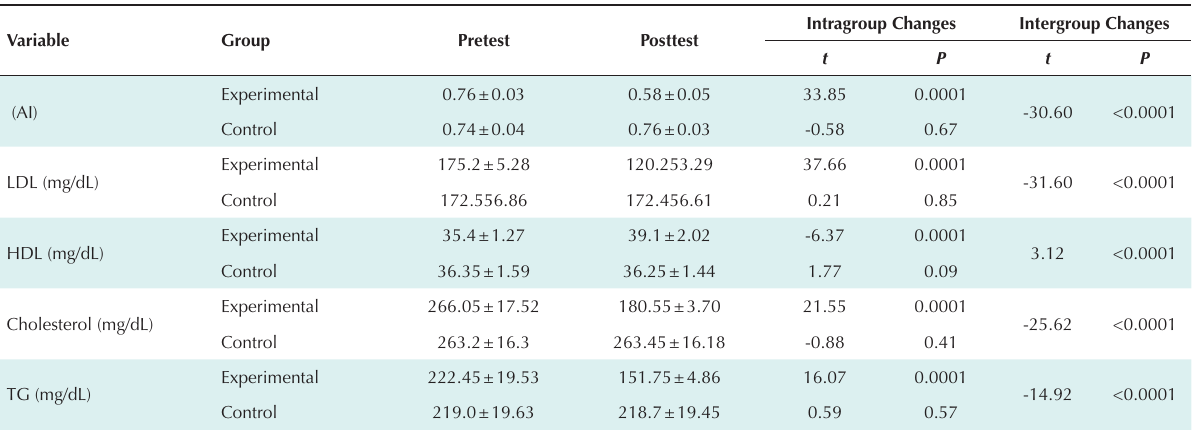
Table 3 . Changes (mean ± SD) of Research Parameters in Experimental and Control Groups Variable Group Pretest